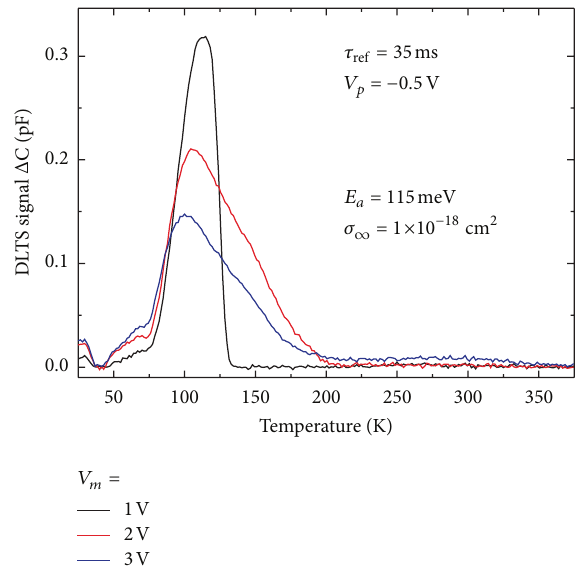
Figure 3: Conventional DLTS measurement for different measure- ment voltages 𝑉 𝑚 and a reference time constant of 𝜏 activation energy corresponds to the measurement at 𝑉 𝑚 = 2 V.